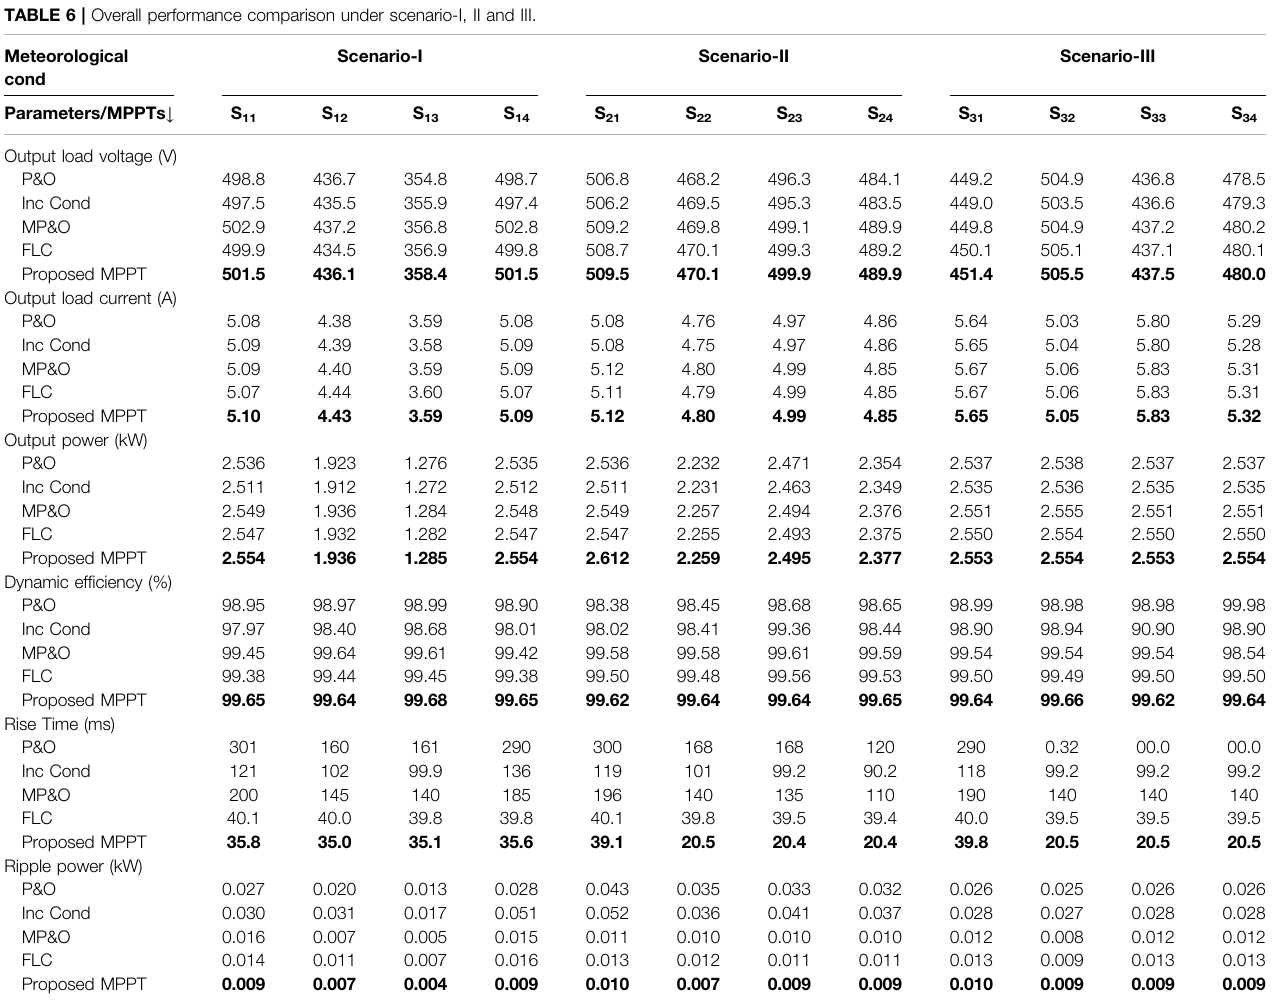
TABLE 6 | Overall performance comparison under scenario-I, II and III. Meteorological